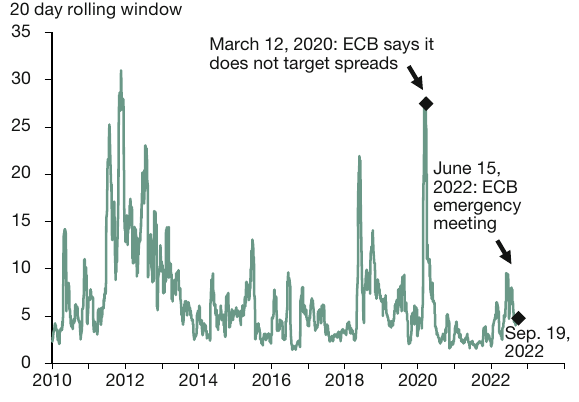
Source: Bloomberg.